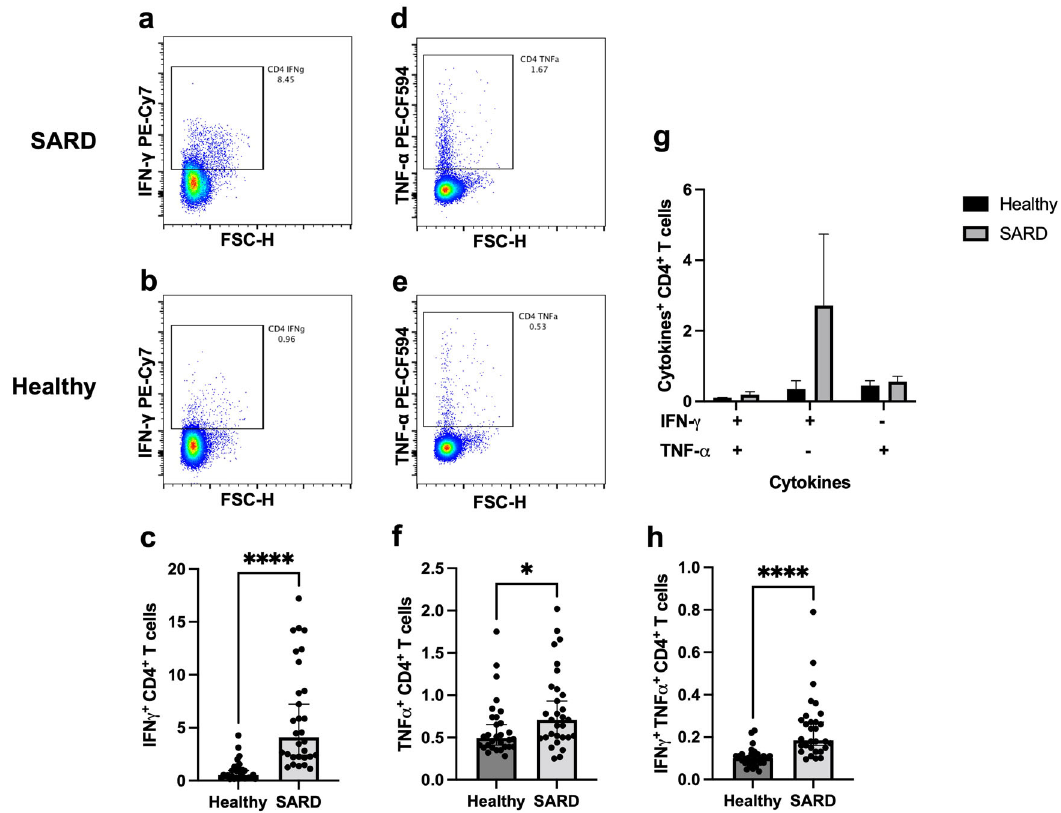
Fig. 4 Effector cytokine-producing CD4 + T cell responses in patients with systemic autoimmune rheumatic diseases and the healthy group. Patients with SARDs and the healthy group were vaccinated with CoronaVac followed by ChAdOx1 nCoV-19 (Oxford-AstraZeneca). Four weeks after vaccination, blood samples were obtained and processed to obtain PBMCs. Frozen PBMCs were thawed and stimulated with S1 peptide pools. Blood samples were processed to obtain PBMCs. The cells were stained for surface markers and intracellular cytokines. Representative fl ow plots of IFN- γ producing CD4 + T cells in ( a ) patients with SARDs and ( b ) the healthy group ( c ) Percentage of IFN- γ producing CD4 + T cell responses. Representative fl ow plots of TNF- α producing CD4 + T cells in ( d ) patients with SARDs and ( e ) the healthy group ( f ) Percentage of TNF- α producing CD4 + T cell responses. g and h Percentages of IFN- γ and TNF- α secreting CD4 + T cells. Each symbol represents one participant and data are presented as the median with 95% CI. Statistical signi fi cance was determined using Mann – Whitney test between groups. * p ≤ 0.05, **** p ≤